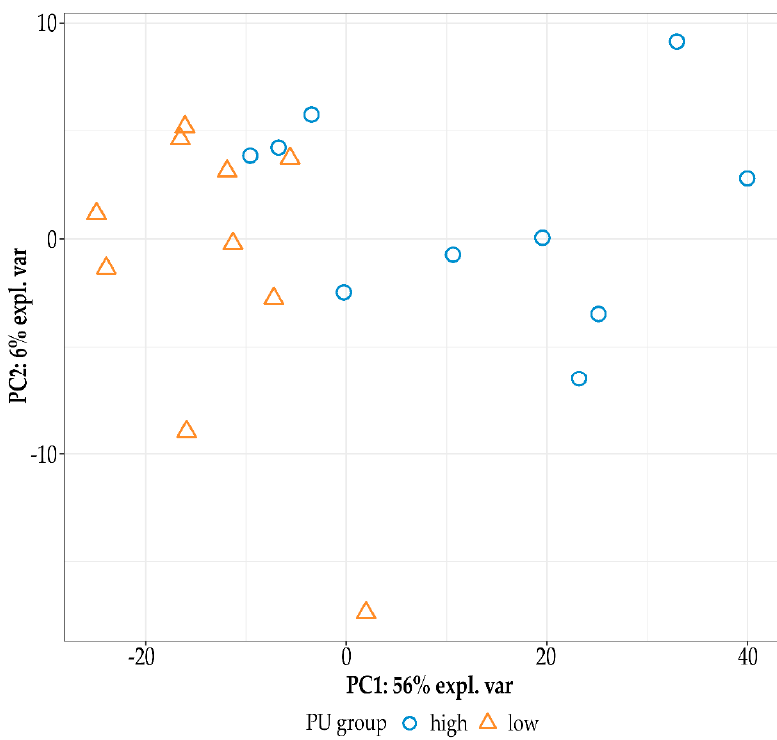
Figure 1. Principal component analysis based on the profiles of differentially expressed genes (q-value ≤ 0.05) in ileum samples of quail exhibiting low (orange triangle) or high (blue circle) phosphorous utilization (PU).